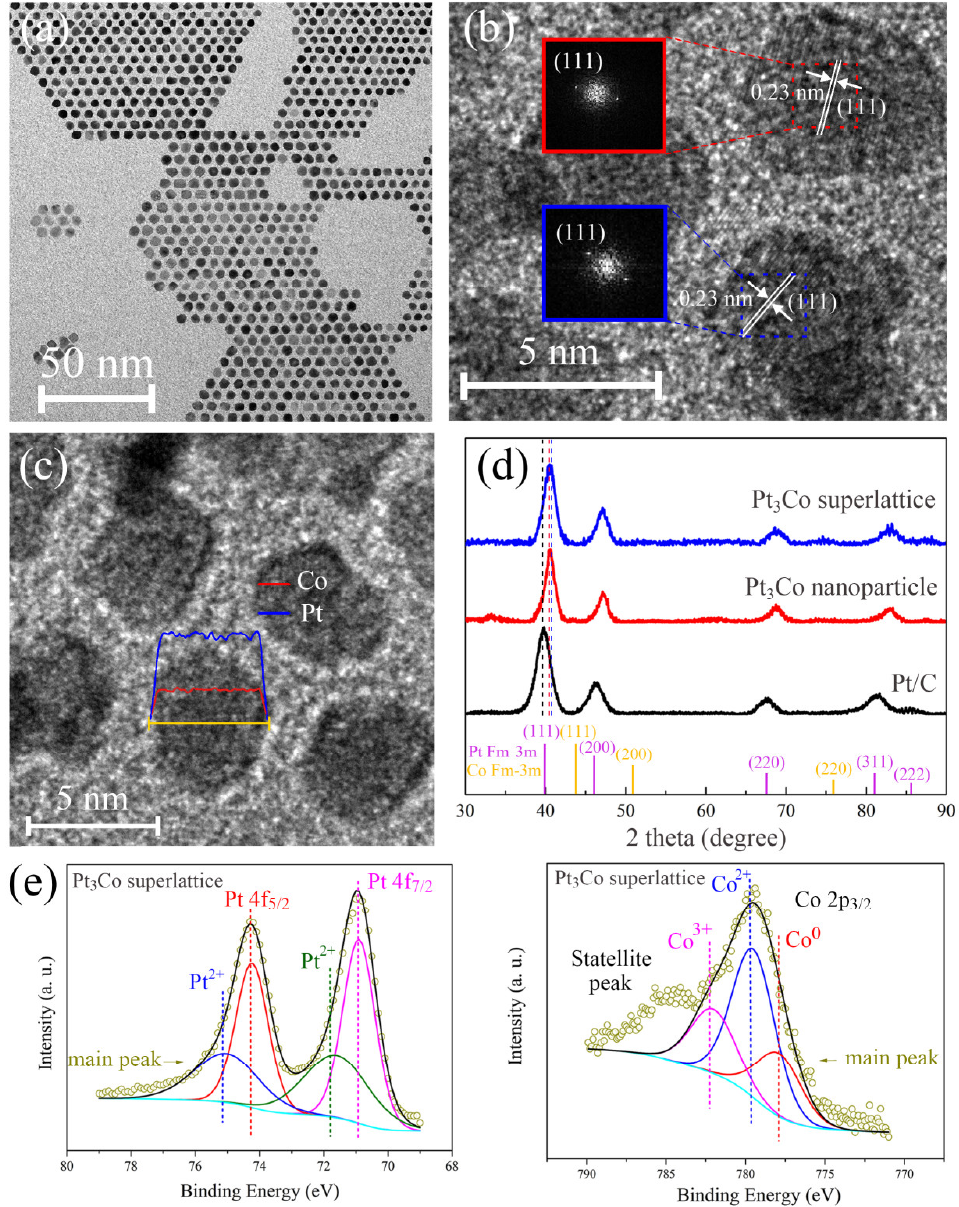
Figure 1. ( a ) TEM image of Pt 3 Co superlattice structure. ( b ) HRTEM image of a single Pt 3 Co particle, and the corresponding FFT patterns are also shown. ( c ) EDS line scan profile of a single nanoparticle. ( d ) XRD pattern of Pt 3 Co superlattice, Pt 3 Co nanoparticles, and Pt/C. ( e ) Pt 4f and Co 2p spectra pattern of Pt 3 Co superlattice.